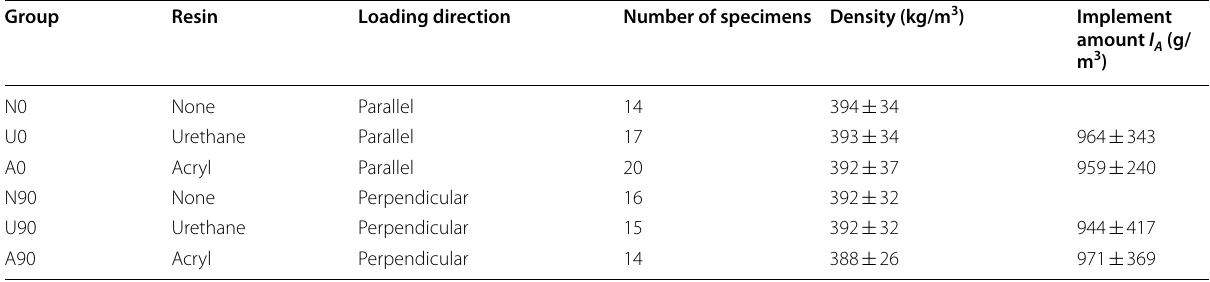
Table 1 Specimen groups used in this study